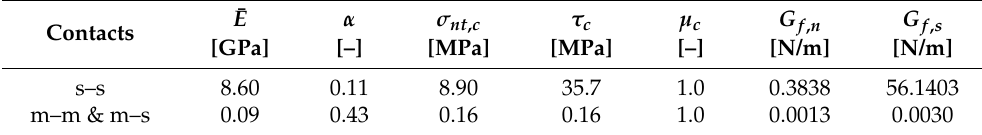
Table 3. Calibrated contact elastic and strength properties [24].